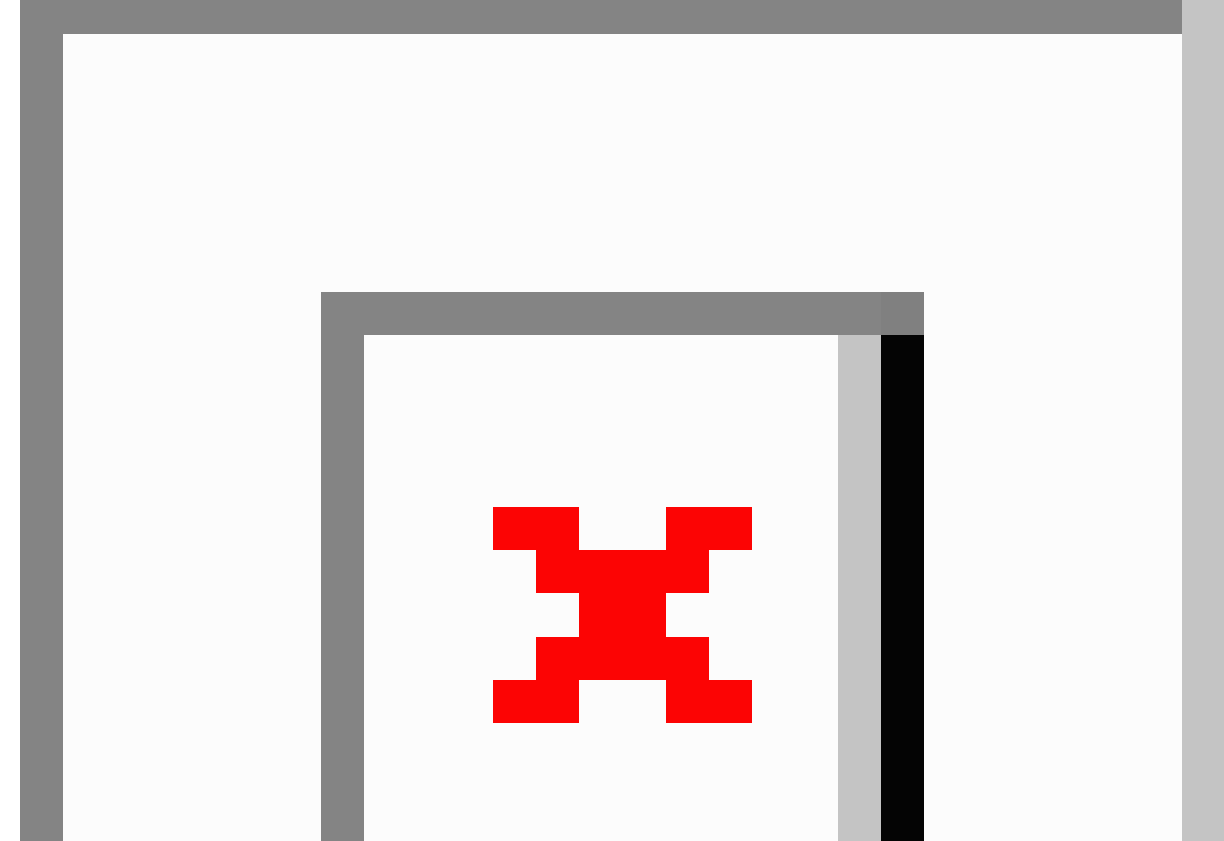
Figure 4. Number of completed reports by participants for each type of response (sensorband or self-initiated). The number of reports includes positive and negatively valenced emotions and personalized emotions